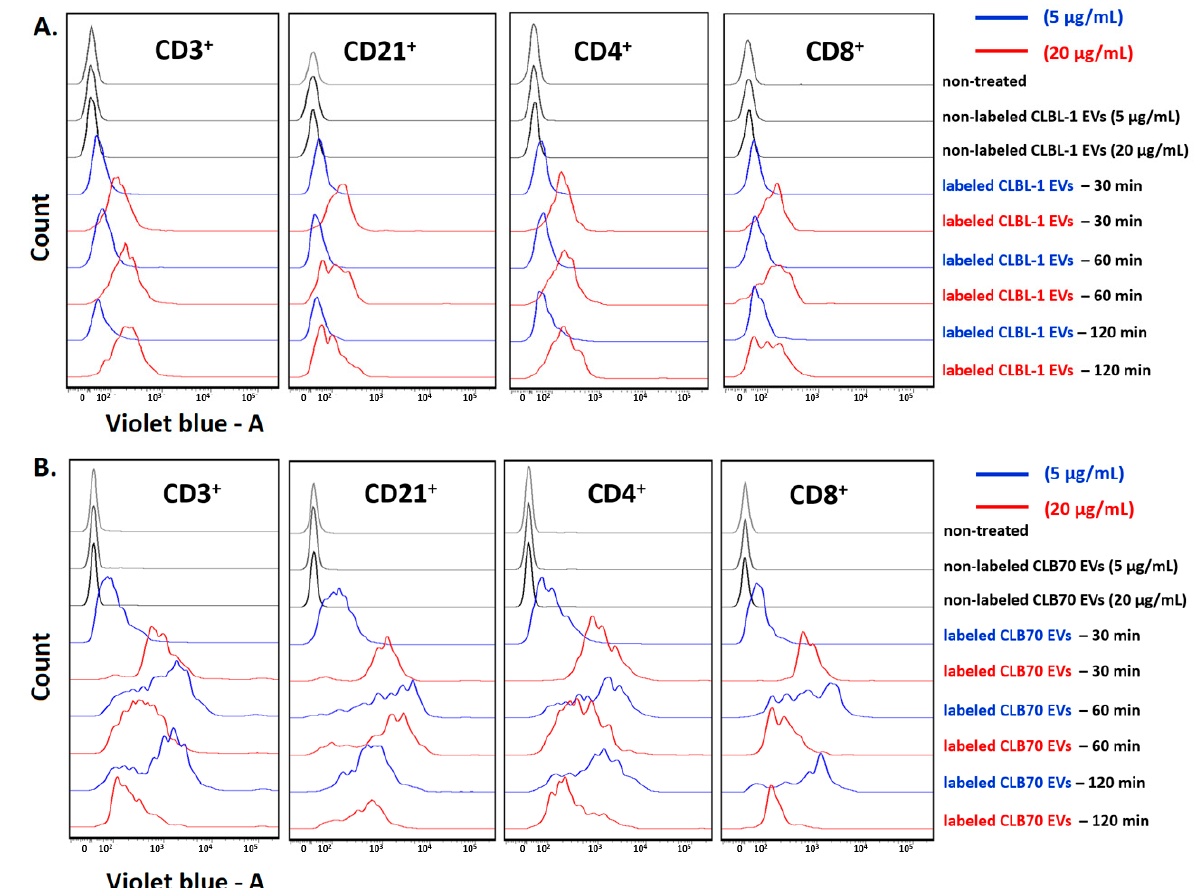
Figure 1. Time-dependent internalization of TEVs by lymphocytes. Flow cytometric analysis of the fluorescence transferred by CLBL-1 EVs and CLB70 EVs into lymphocytes. The staining of directly labeled cells and the negative control cells (gray lines) after 30, 50, and 120 min of incubation are shown. ( A ) the kinetics of two concentrations of CLBL-1 EVs taken up by: CD3 + T lymphocytes, CD21 + B lymphocytes, CD4 + T lymphocytes, and CD8 + T lymphocytes. ( B ) The kinetics of two concentrations of CLB70 EVs taken up by: CD3 + T lymphocytes, CD21 + B lymphocytes, CD4 + T lymphocytes, and CD8 + T lymphocytes.